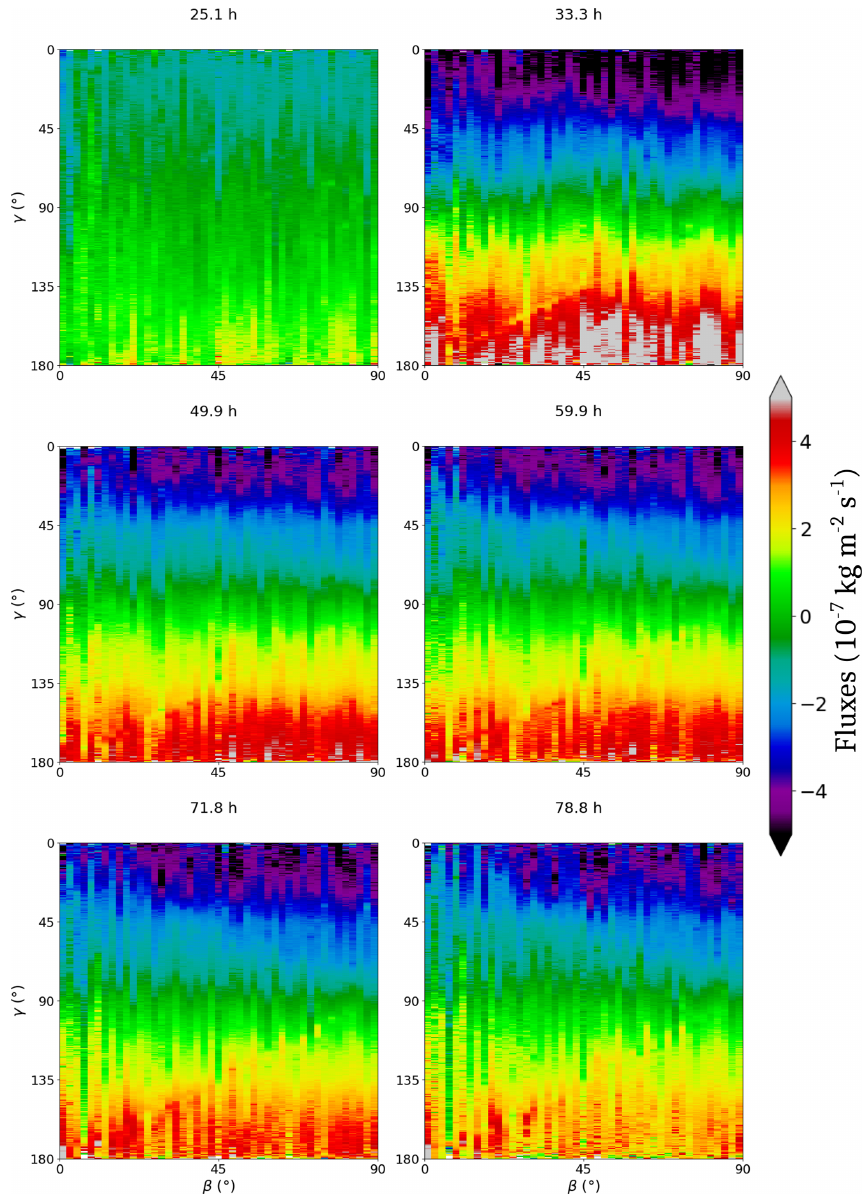
Figure 18. Mean fluxes against β = ( z , c ) and γ = ( z , n ) .